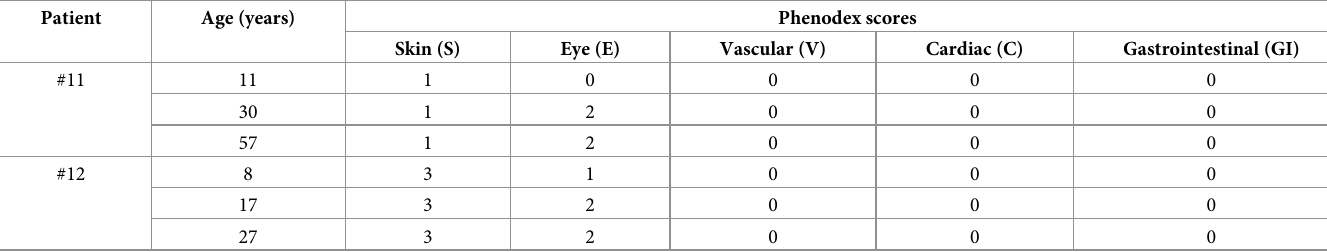
Table 1. Phenodex scores of patients diagnosed with PXE.